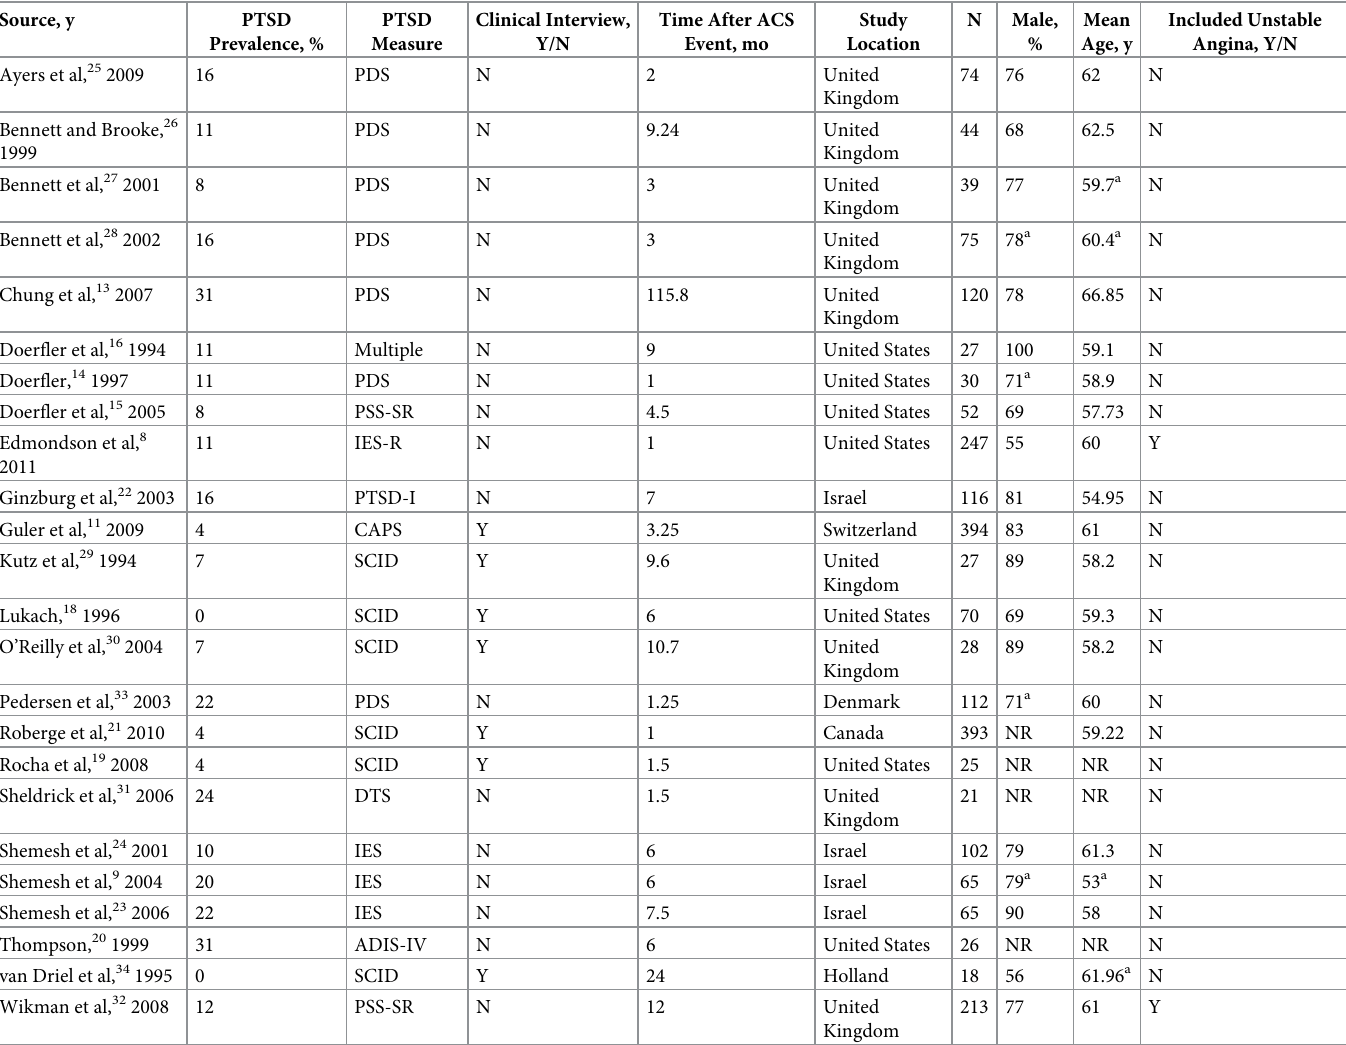
Table 1. Characteristics of Studies on the Prevalence of ACS-Induced